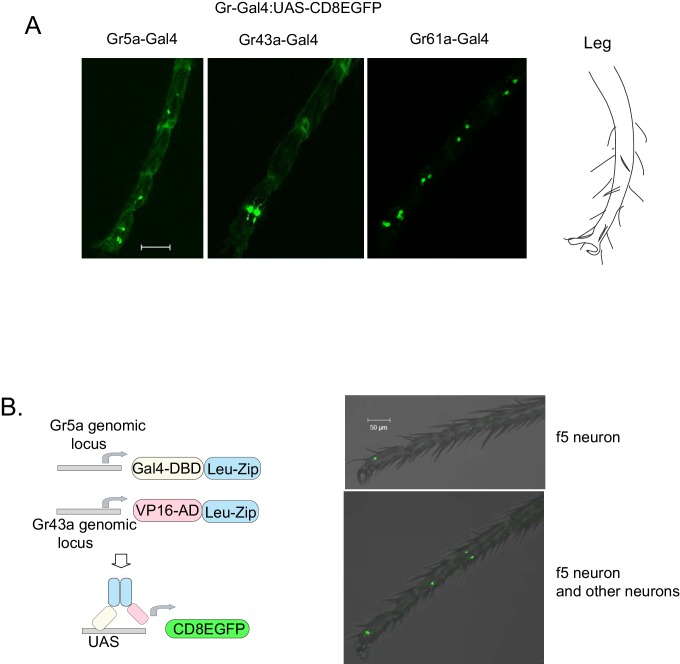
Expression patterns of Gr-GAL4s.(A) Distal tarsi expression patterns of Gr5aGAL4 (3 neurons), Gr43aGAL4 (2 neurons), and Gr61aGAL4 (6 neurons). Scale bar 50 μm. (B) Gr5a-Gr43a splitGal4 labeling (Pfeiffer et al., 2010). GAL4 DNA-binding domain (DBD) and VP16 transcription activation domain (AD) fused to leucine zipper dimerization domains (Leu-Zip) were inserted into the Gr5a (DBD) and Gr43a (AD) genomic locus using CRISPR-Cas9. The neurons coexpressing both receptors drive mCD8eGFP from the UAS promoter. f5 neurons in the distal tarsi are marked by this technique. In some animals, an f5 neuron is the only neuron marked (top panel). However, in other animals, additional neurons were also marked in the leg (bottom panel) and proboscis. Scale bar 50 μm.